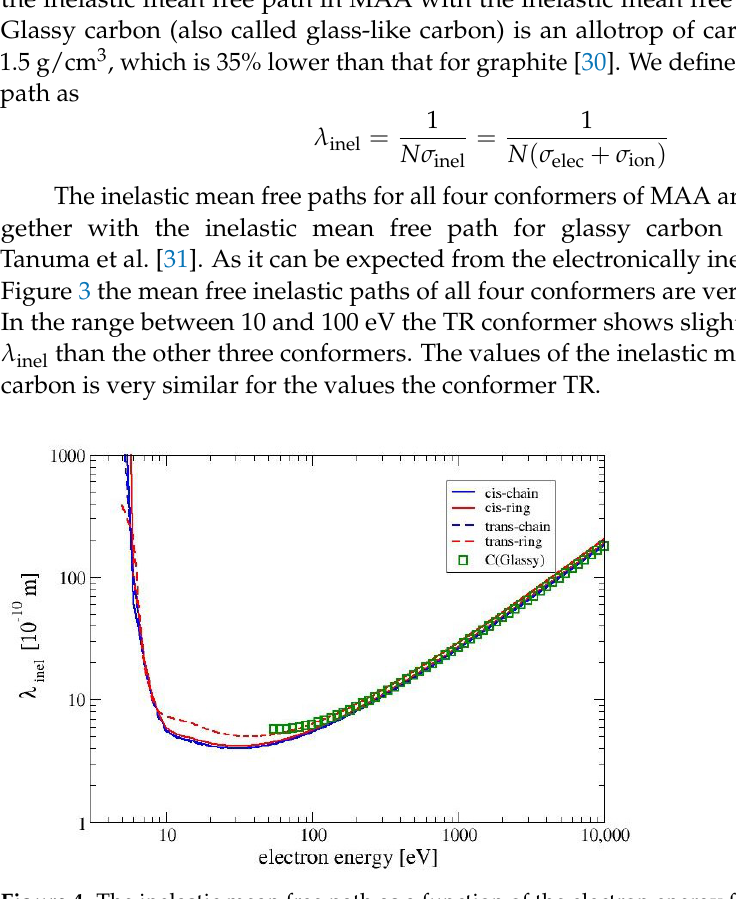
Figure 4. The inelastic mean free path as a function of the electron energy for the four conformers of MAA. Shown also are the values for glassy carbon from calculations by Tanuma et al.